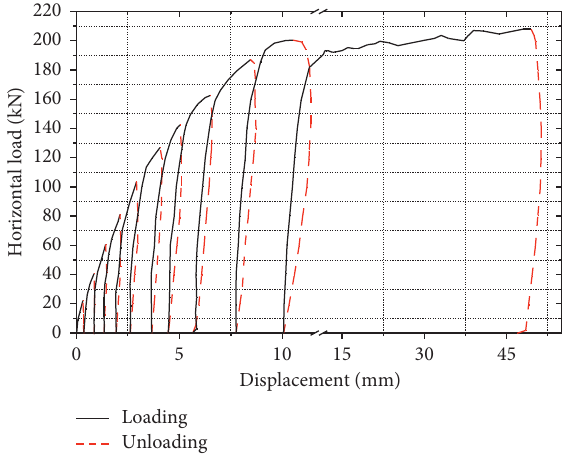
Figure 21: Load-displacement curve under cyclic